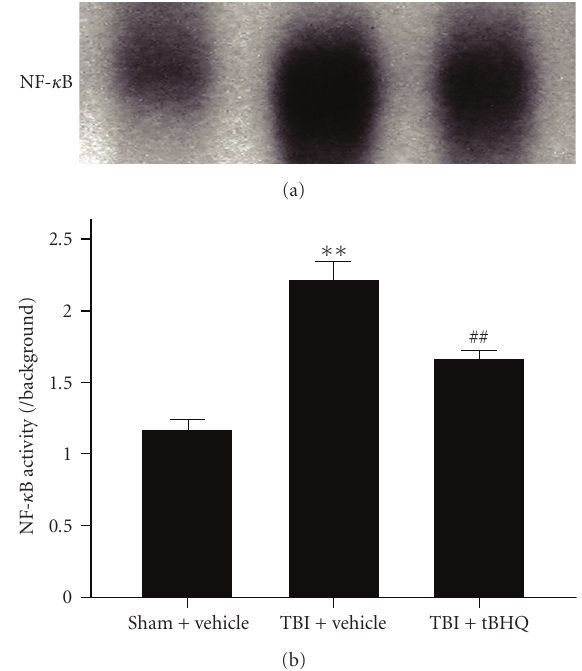
Figure 1: NF- κ B binding activity in the intestinal tissue in sham + vehicle group, TBI + vehicle group, and TBI + tBHQ group ( n = 6). EMSA autoradiography of NF- κ B DNA binding is shown on top of the graph, and the order of individual bands corresponds to that of graph bars. Lane 1: sham + vehicle group; lane 2: TBI + vehicle group; lane 3: TBI + tBHQ group. tBHQ treatment markedly suppressed the activation of NF- κ B in the gut following TBI. ∗∗ P < . 01 versus sham + vehicle group; ## P < . 01 versus TBI + vehicle